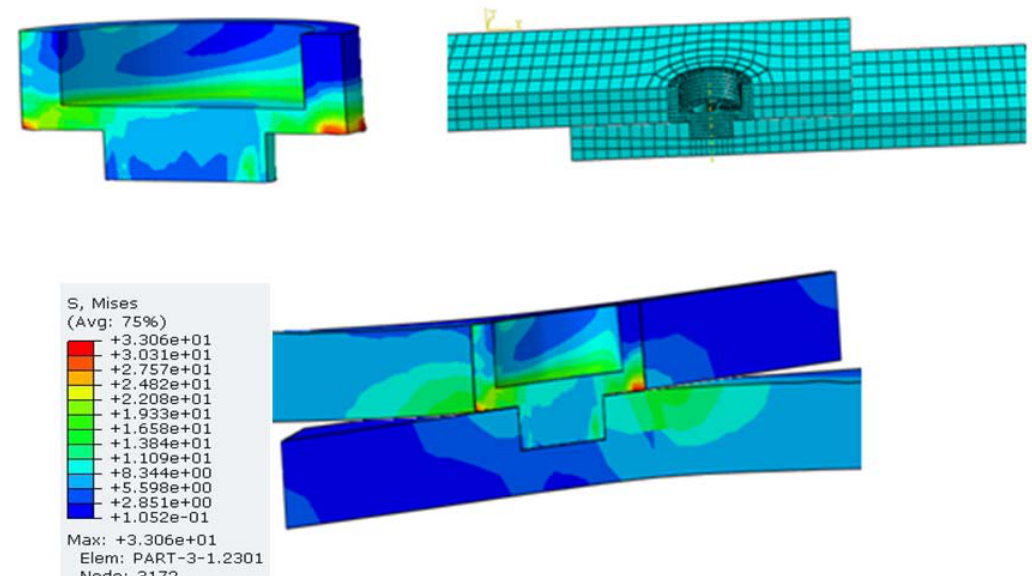
Figure 13: Numerical result for a weld